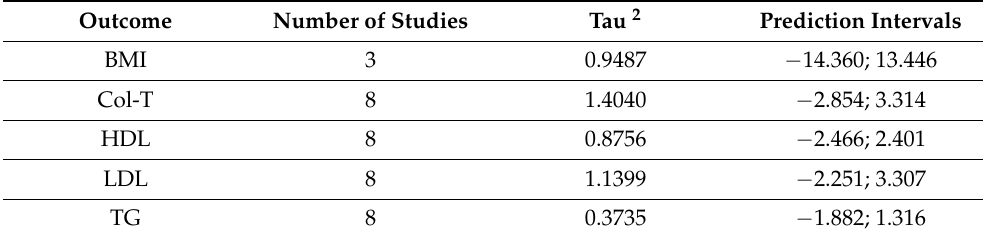
Table 3. Prediction intervals for estimating the actual mean difference in